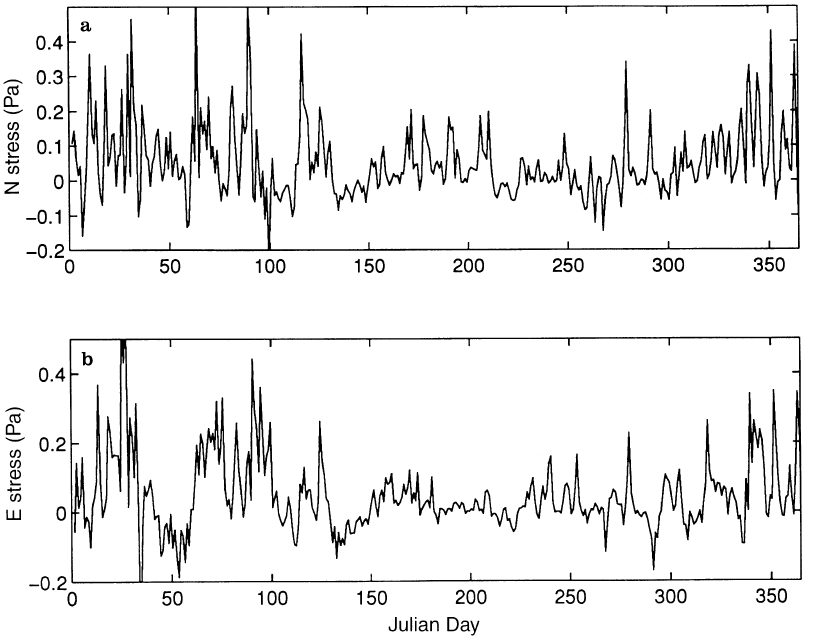
Fig. 8a, b. Time-series of a northerly and b easterly wind stress measured at the Irish Meterological Station at Belmullet (54 : 228 (cid:14) N, 10 : 007 (cid:14) W)